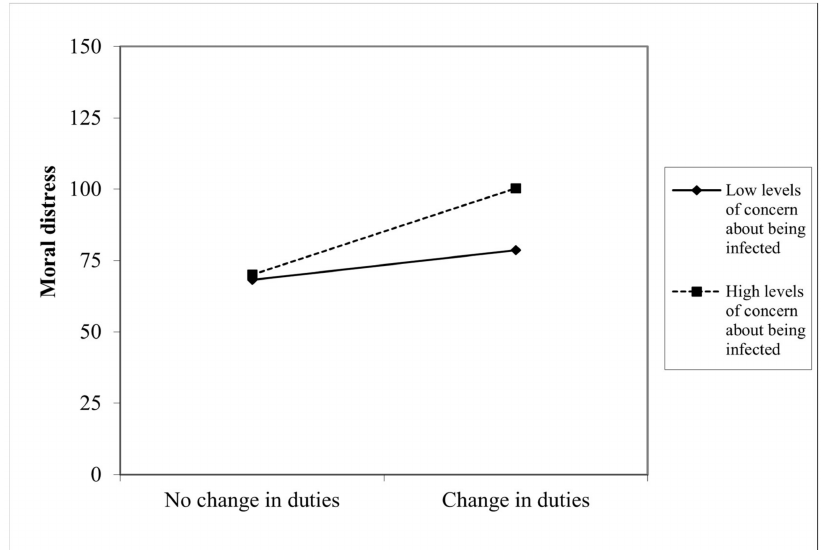
Figure 3. Moderating effect of concern about being infected with COVID during